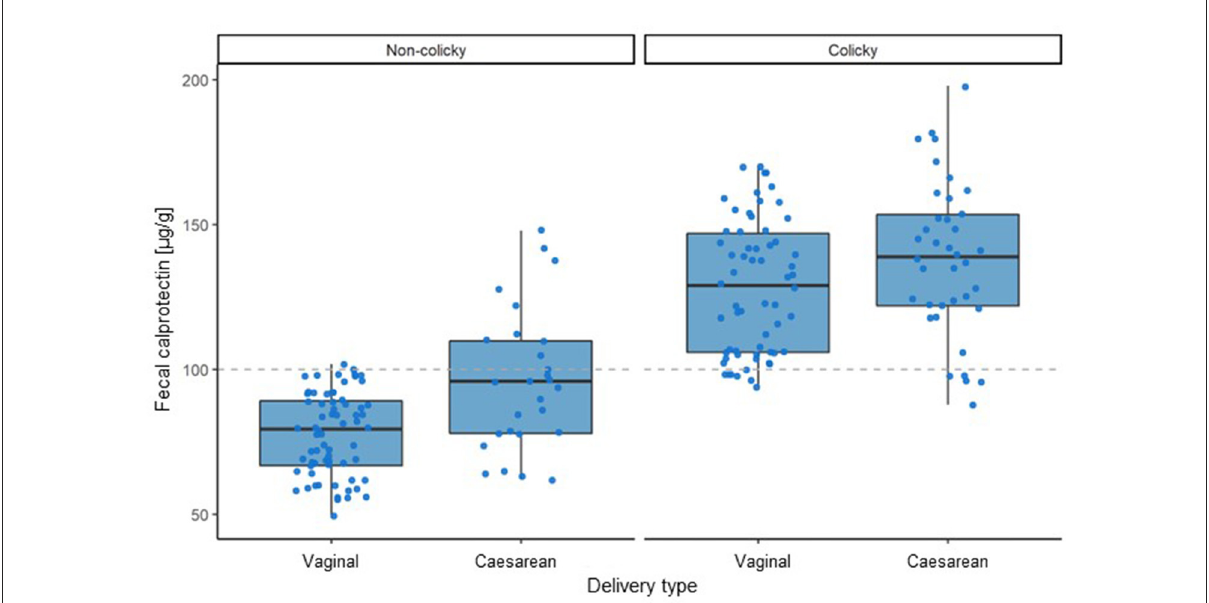
FIGURE3 Influence of type of delivery on fecal calprotectin levels in colicky and non-colicky infants.